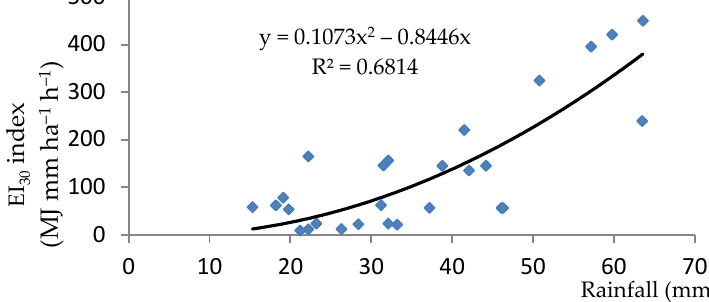
Figure 3. Rainfall erosivity index EI 30 in dependence on rainfall amount.